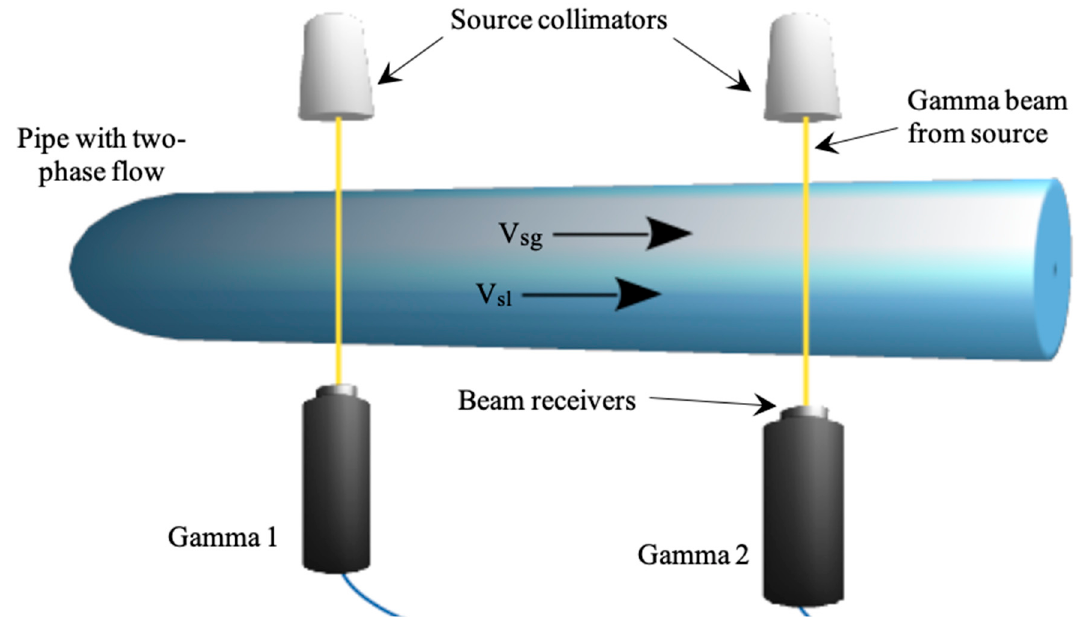
Figure 3. Representation of the installed gamma radiation source on the test section.